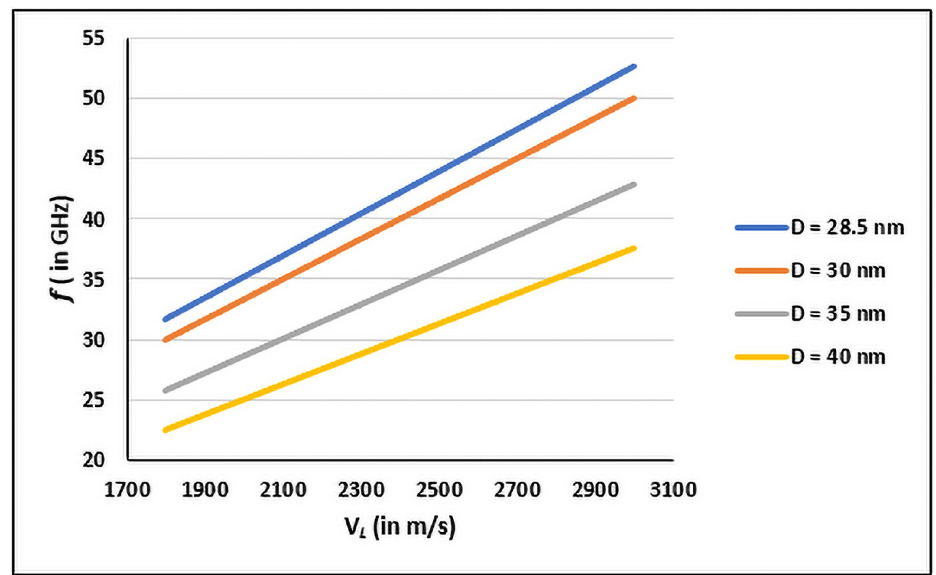
Fig 2. Resonant frequencies f (in GHz) corresponding to respective V L (in m/s) for different diameters D (in nm) of EV71 virus.